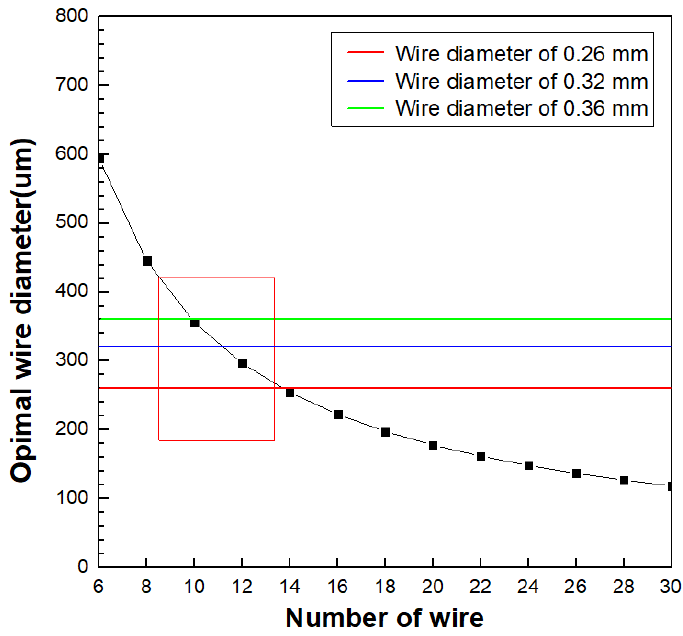
Figure 6. Optimal wire diameter according to the number of wires.